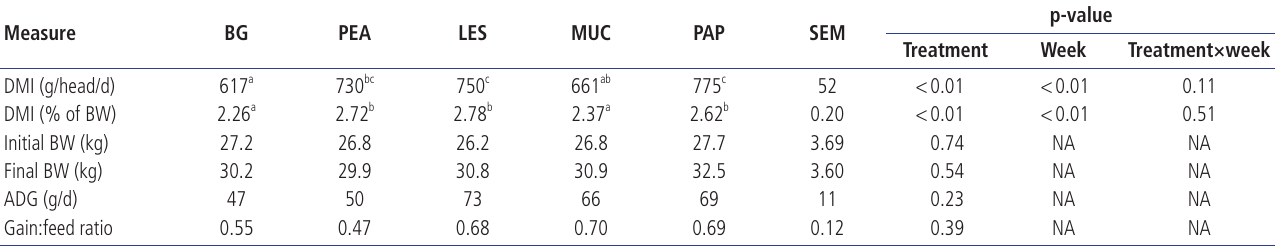
0.000.010.020.030.040.050.060.070.080.090.10 Figure 3. Effects of supplementing bahiagrass (BG) hay with perennial peanut (PEA), lespedeza (LES) hay, mucuna (MUC), or papaya seeds (PAP) on plasma haptoglobin concentrations. Treatment×time, p<0.05. Error bars are standard errors. * Counts at the week specified differed (p<0.05). Table 8. Effects of supplementing bahiagrass (BG) hay with perennial peanut (PEA), lespedeza (LES) hay, mucuna (MUC), or papaya seeds (PAP) on the performance of goats Measure